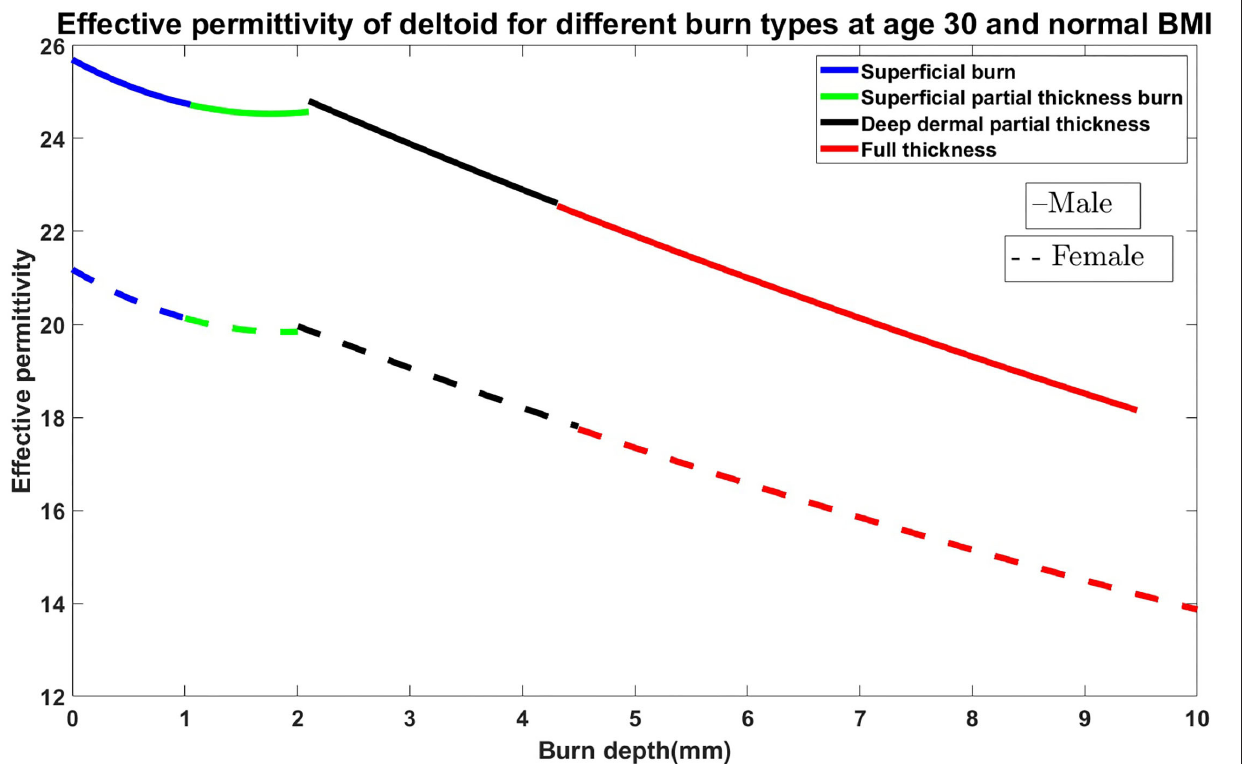
FIGURE 1 | Effective permittivity of the burned skin vs. burn degree for the case of 30 years old male and female on the deltoid region with normal BMI.